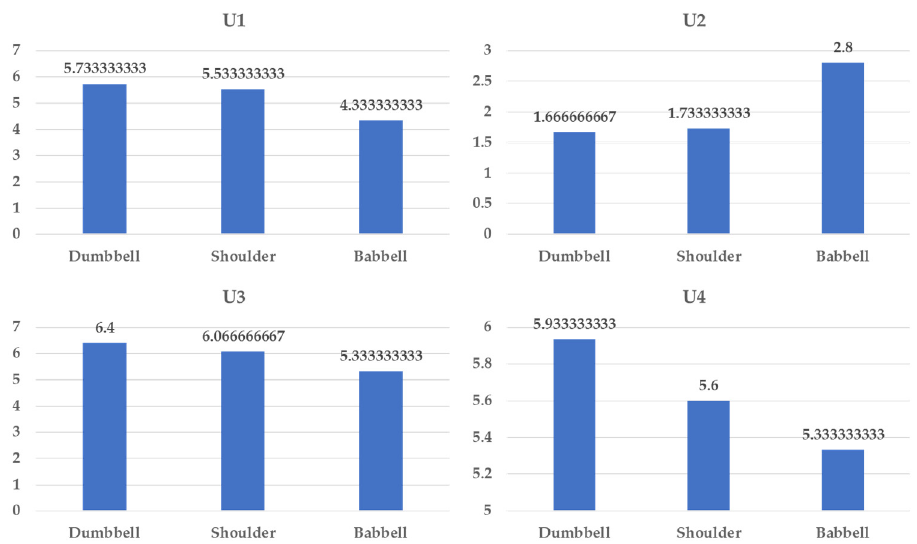
Figure 16. Results of average points of the questionnaires for the evaluation of user interaction. Table 10. Results of the ANOVA test on the interaction in Experiment 2.